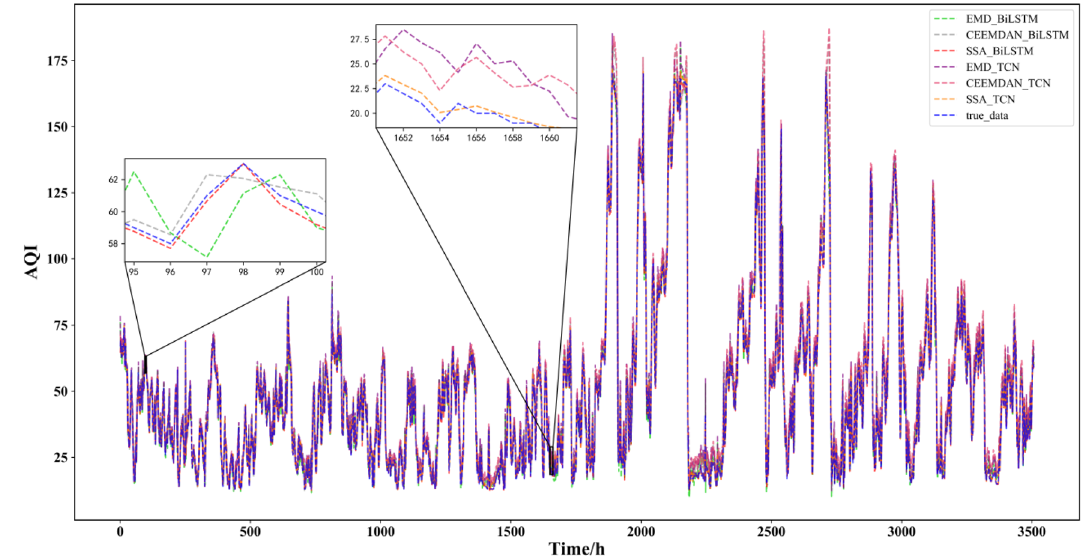
Figure 10. Prediction experimental results of combination models based on decomposition.